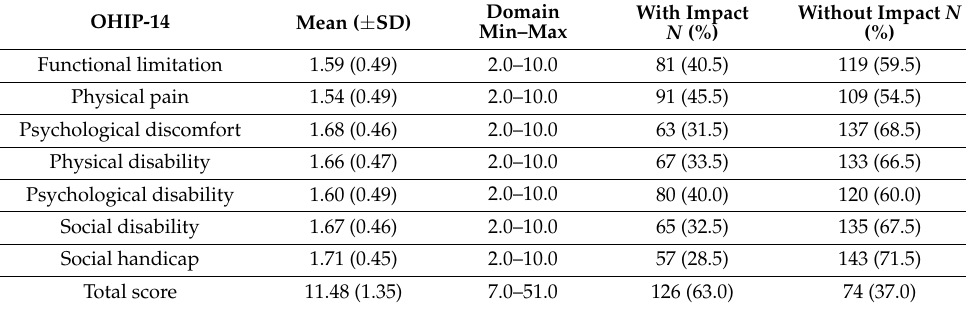
Table 3. Mean OHIP-14 domain scores and prevalence of